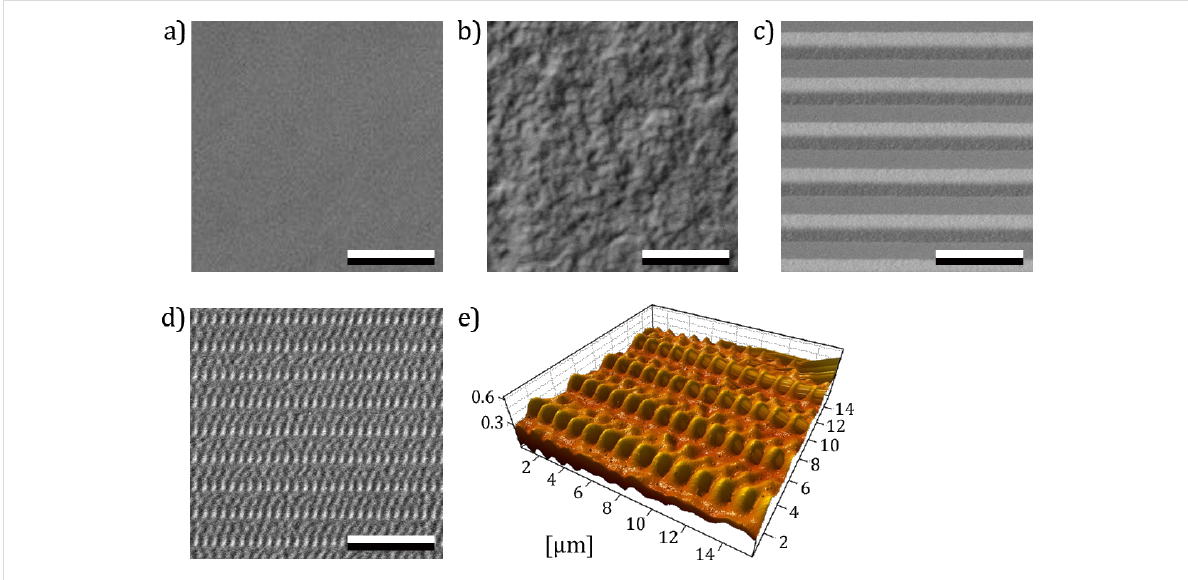
Figure 3: SEM (a–d) and AFM (e) micrographs of epoxy resin polymer moulds of different types of surfaces used in experiments. a) Smooth surface. b) Randomly rough surface with a grain size of 0.3 µm. c) Surface with periodically groove-like microstructures with a structural wavelength of 5 µm. d) SIMPS. Scale bars = 10 µm. e) 3D surface profile of the SIMPS.